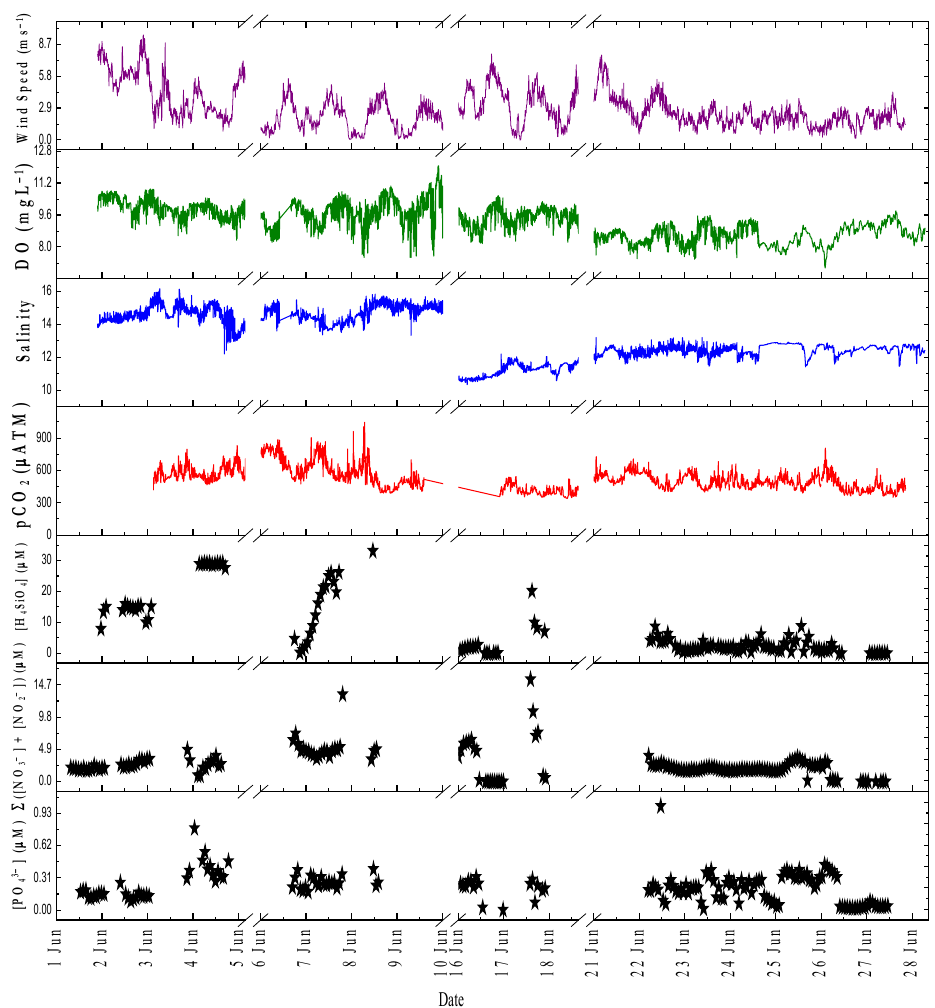
Figure 9. Time series data for the period from 2 June to 10 June 2021 and from 17 June to 27 June. June 2021 for PO 4 3 − , Σ (NO 3 − + NO 2 − ), and H 4 SiO 4 in µ M represented by black stars; pCO 2 in µ atm (red lines), DO in mgL − 1 (green lines), salinity (blue lines), and wind speed in ms − 1 (purple